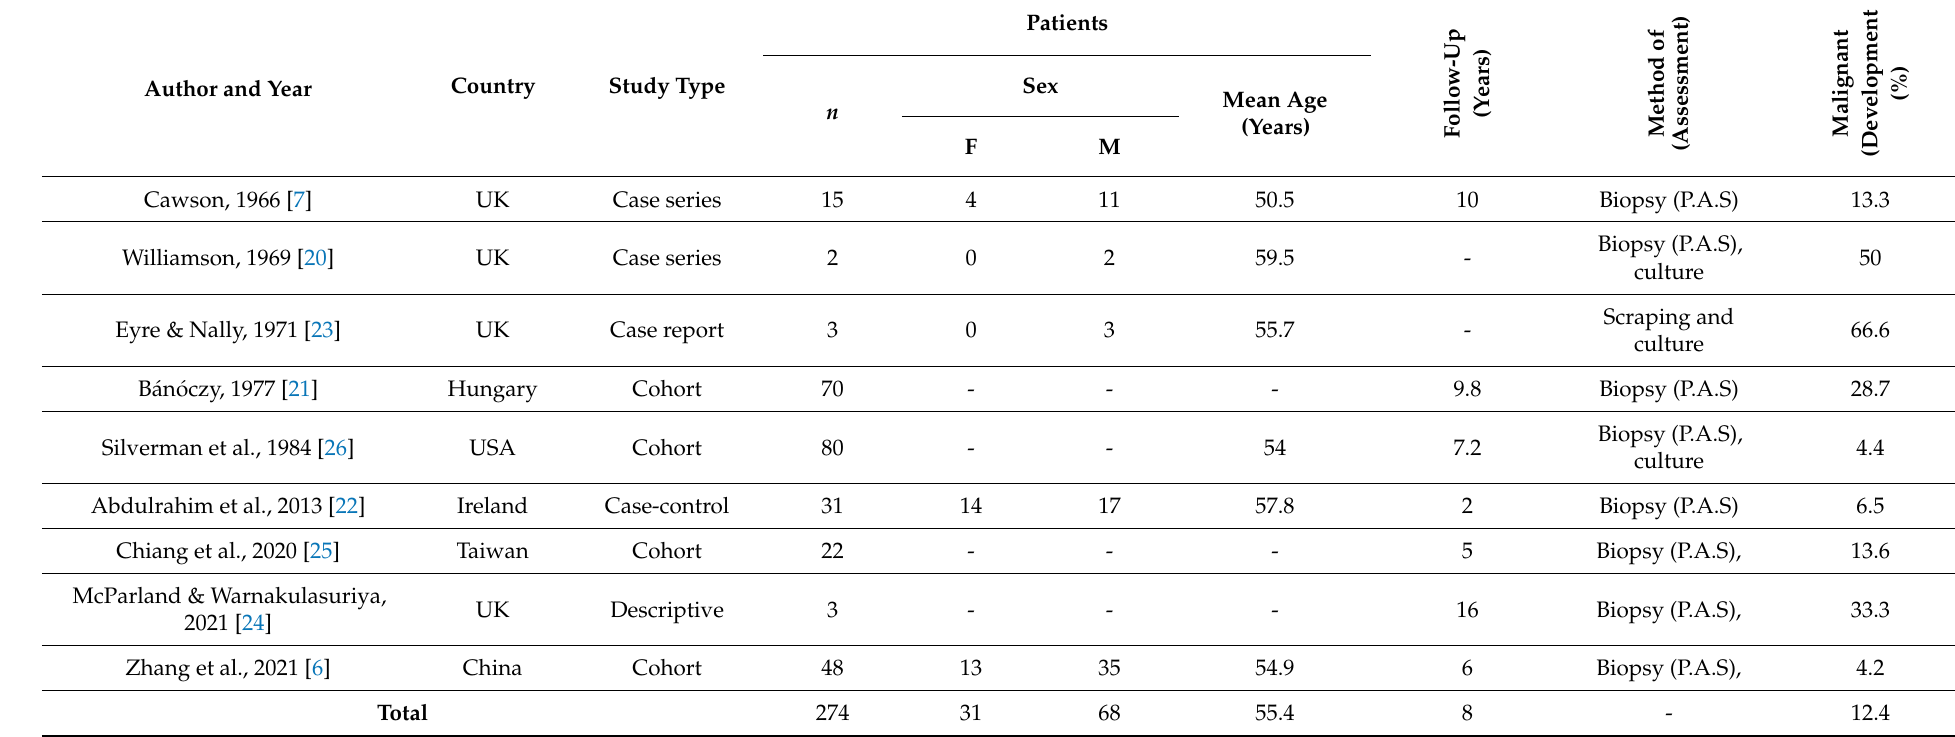
Table 1. Main clinicodemographic data of patients with CHC included in the study (F: female; M: male; n :